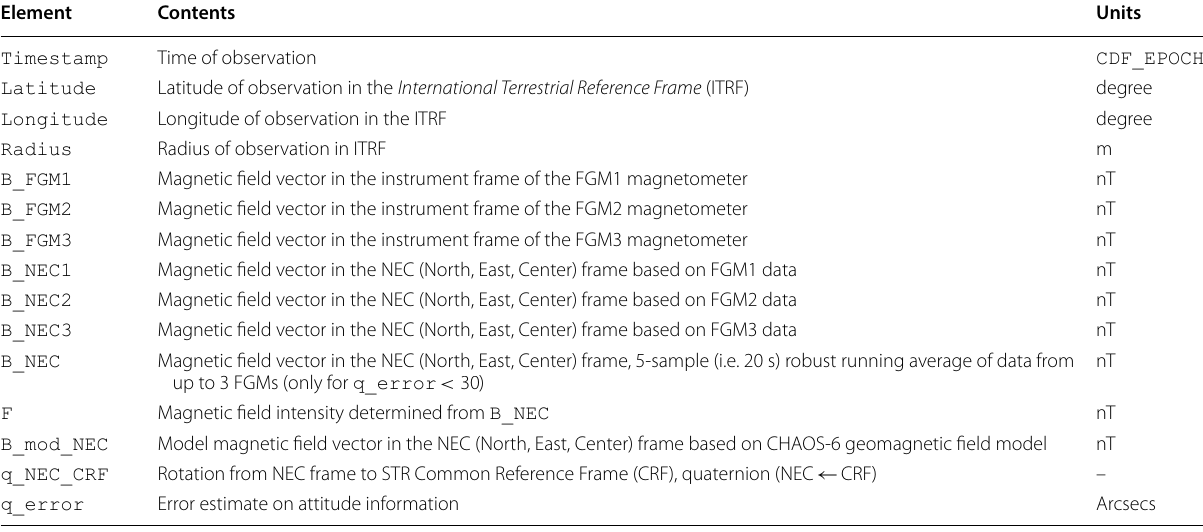
Table 3 Content of CryoSat-2 magnetic data